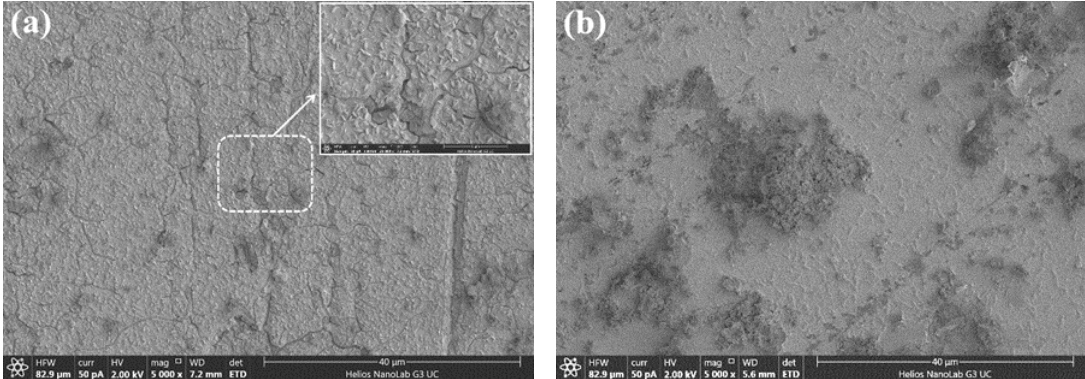
Figure 4. SEM images for the surfaces of arsenopyrite cuboids after bioleaching 36 h in 9K culture medium ( a ) without and ( b ) with 5 mg/L Ag + .